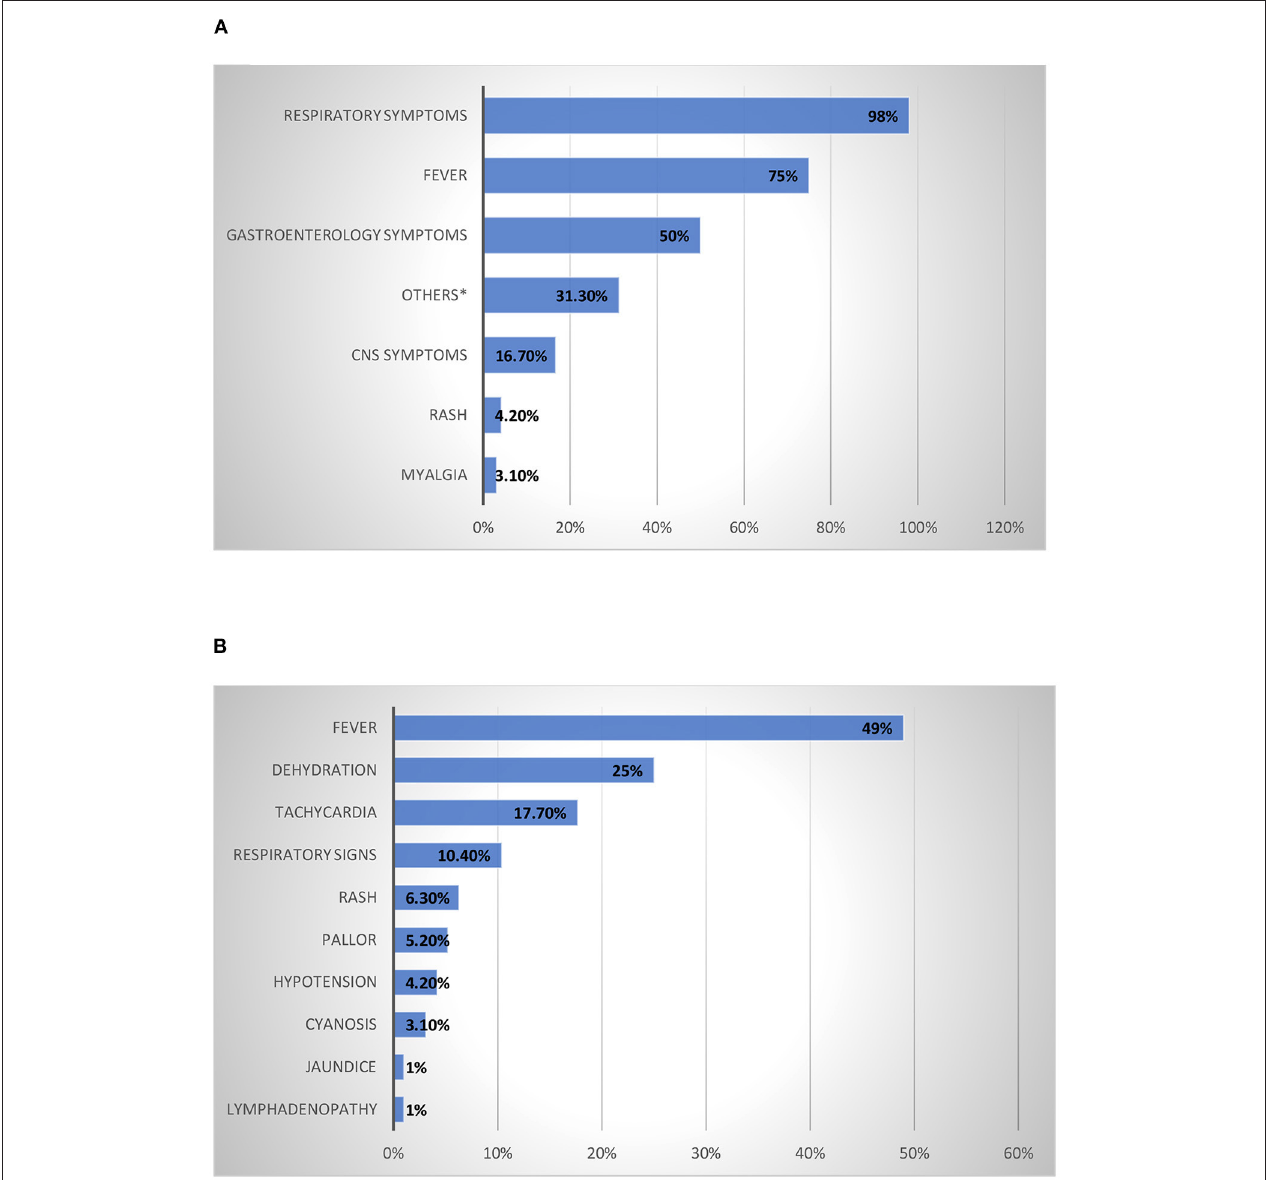
FIGURE 1 | Presenting Symptoms and Physical Signs of Children Admitted with A Confirmed Diagnosis Of COVID-19. (A) Presenting symptoms of children admitted with a confirmed diagnosis of COVID-19 infection. *Decrease activity and decrease appetite. (B) Physical signs of children admitted with confirmed diagnosis of COVID-19